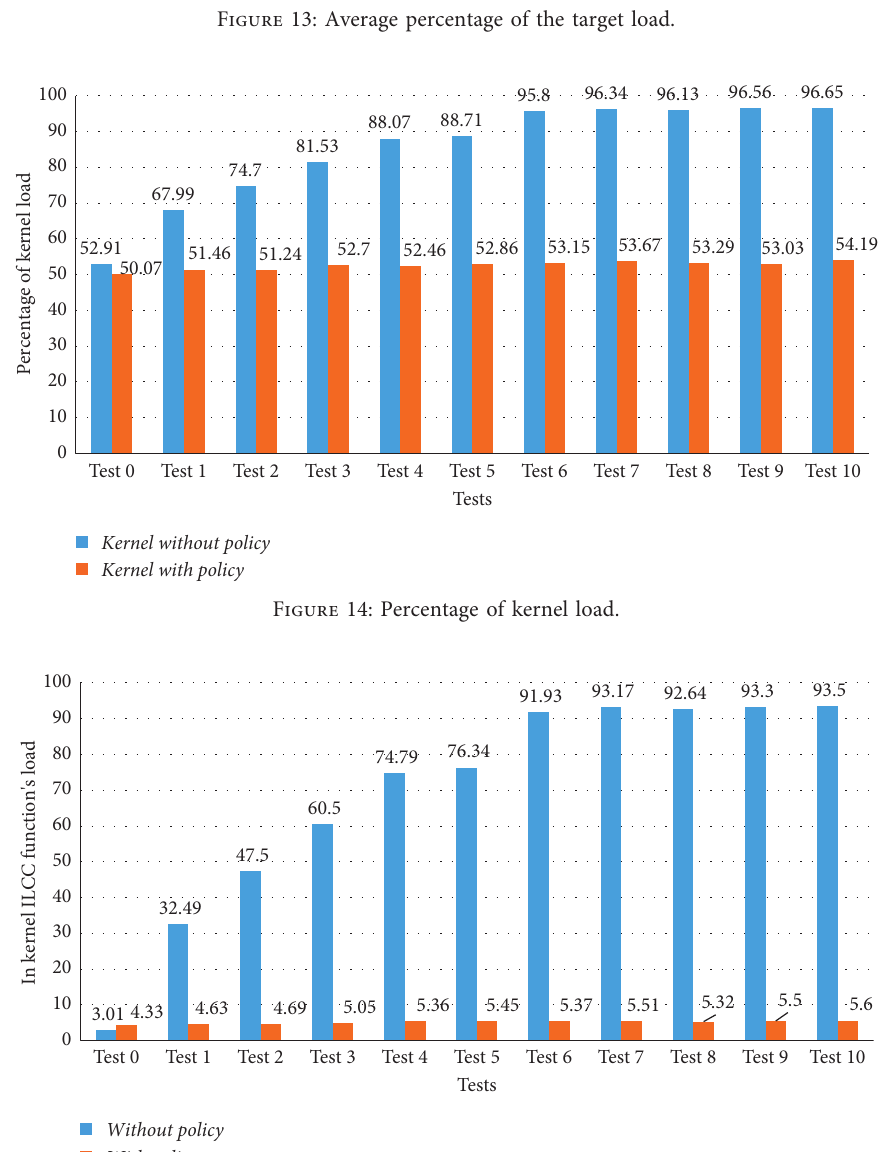
Figure 13: Average percentage of the target load.